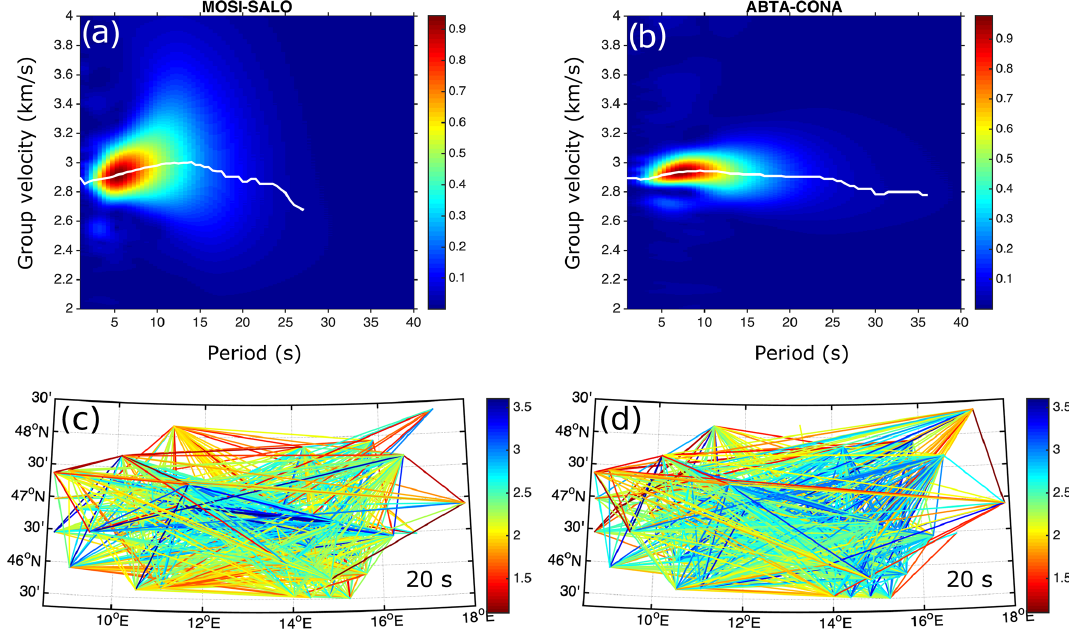
Figure 3. (a, b) Example of a normalized period–group velocity diagram from (a) MOSI-SALO and (b) ABTA-CONA. The white line represents the extracted dispersion curve. (c, d) Example of velocity measurements at a 20s period for (c) Rayleigh waves and (d) Love waves. Note that stable high- and low-velocity zones can be seen in the velocity measurements. See Supplement Fig. S2 for more examples of period–group velocity diagrams.